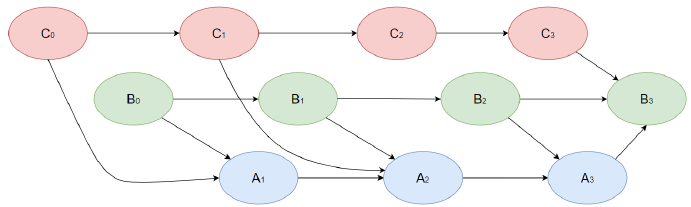
Figure 2. DAG-example of a dynamic Bayesian network .